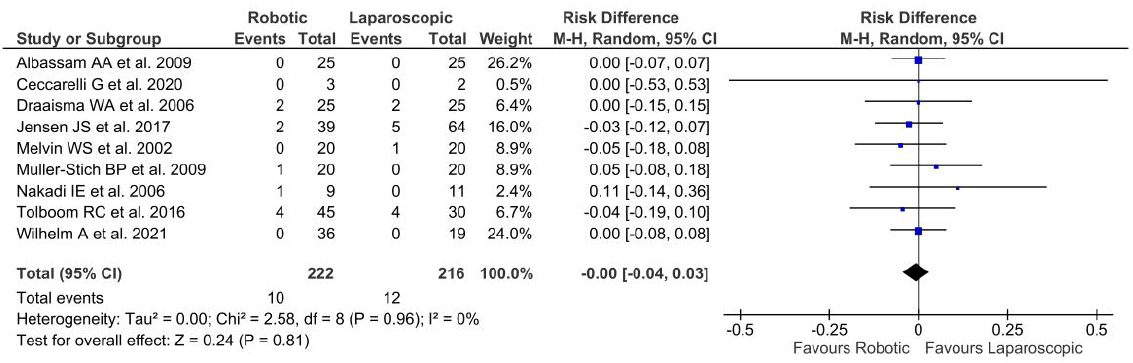
Figure 7. Forest plot of laparoscopic vs. robotic reoperation rates [22,25,27,30,33,34,36,37]